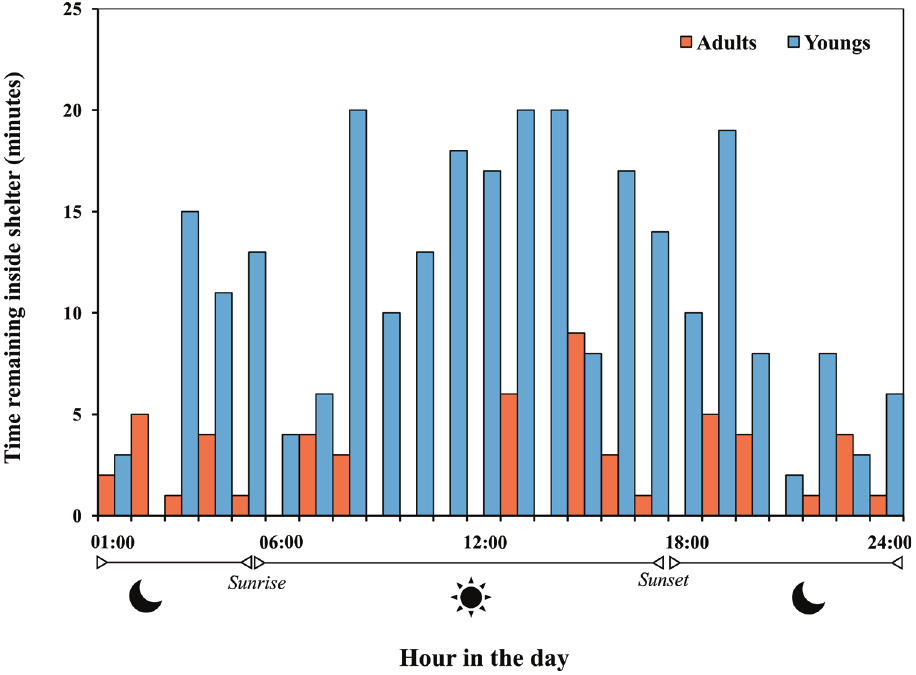
Figure 6. Difference between time remaining inside shelters in juveniles (n = 5) and adults (n = 12)